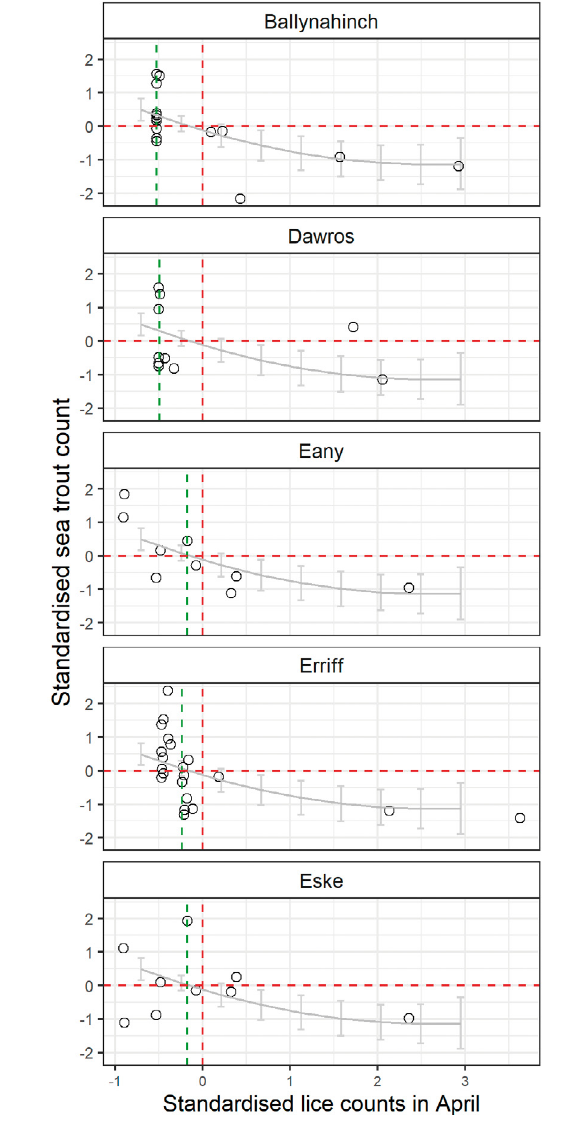
Fig. 4. Standardised annual counts of sea trout (open circles) for each study river in relation to standardised louse counts on the nearby salmon farm site in April. Grey solid line is pre- dicted sea trout runs from Model 12 (see Tables 2 & 3), with 95% credible intervals. The louse count thresholds (dashed green vertical line: 50 th percentile; dashed red vertical line: mean) are shown for each river to illustrate how observed and predicted sea trout runs decline across the observed louse pressure gradient. The red dashed horizontal zero line repre- sents the mean standardised annual return to each river